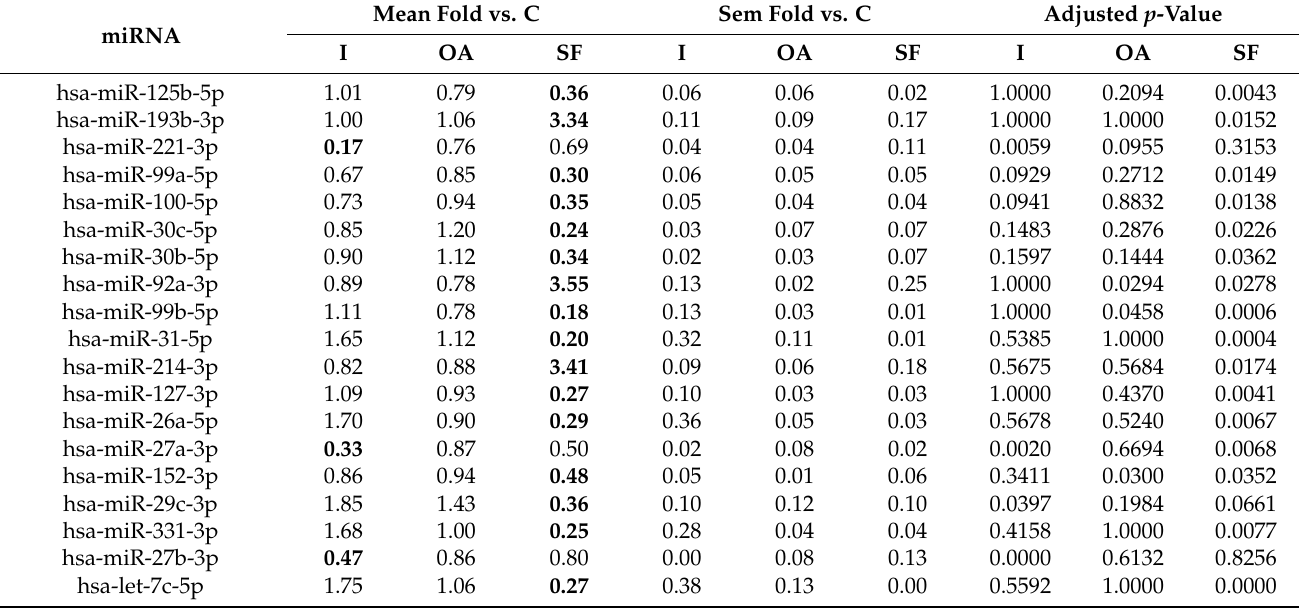
Table 1. First-quartile differentially expressed EV-miRNAs with respect to C condition. Mean Fold vs. C Sem Fold vs. miRNA